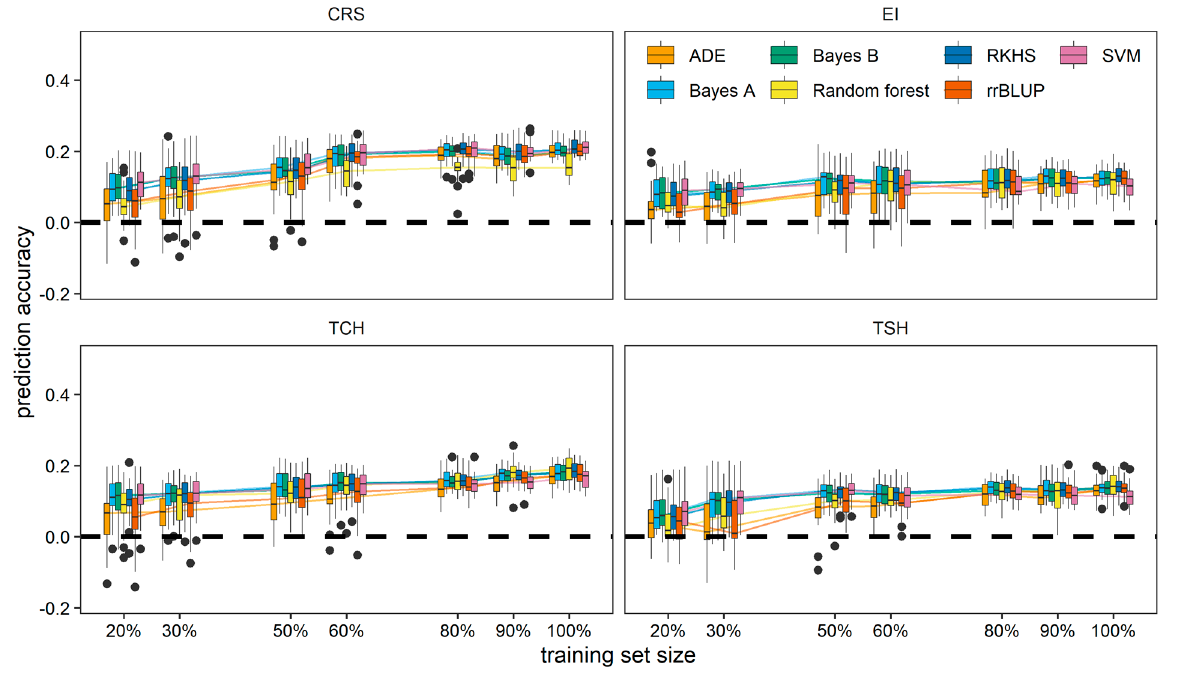
Figure 8. The effect of training population size (percentages) on genomic selection (GS) prediction ability for four secondary traits: commercial recoverable sugar (CRS), economic index (EI), ton cane per hectare (TCH), and ton sugar per hectare (TSH). The plant cane phenotypic data were used.